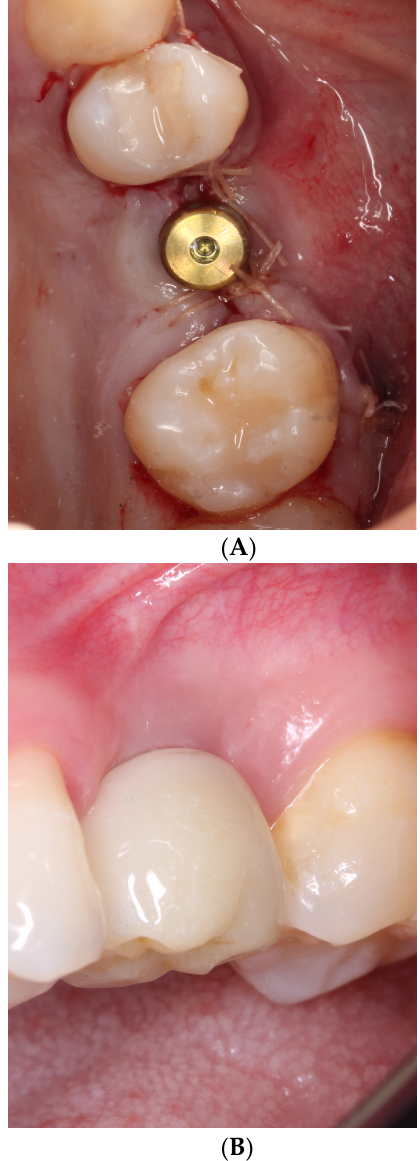
Figure 3. ( A ): Implant placement at the end of surgery. ( B ): Clinical follow-up at 2 years.